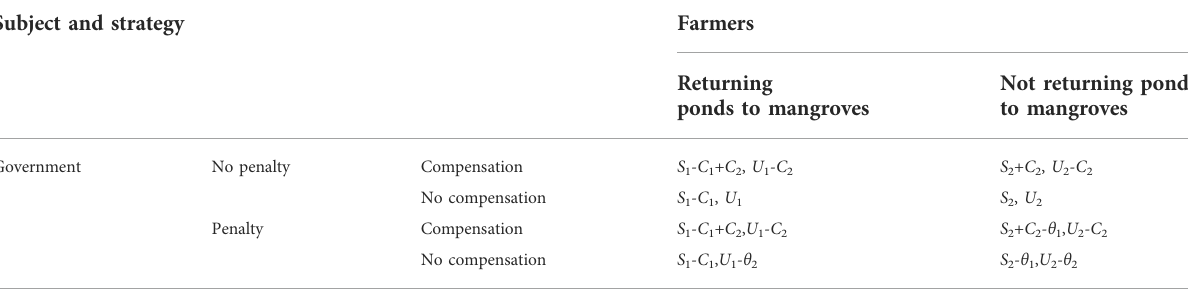
TABLE 4 The game between the government and farmers.